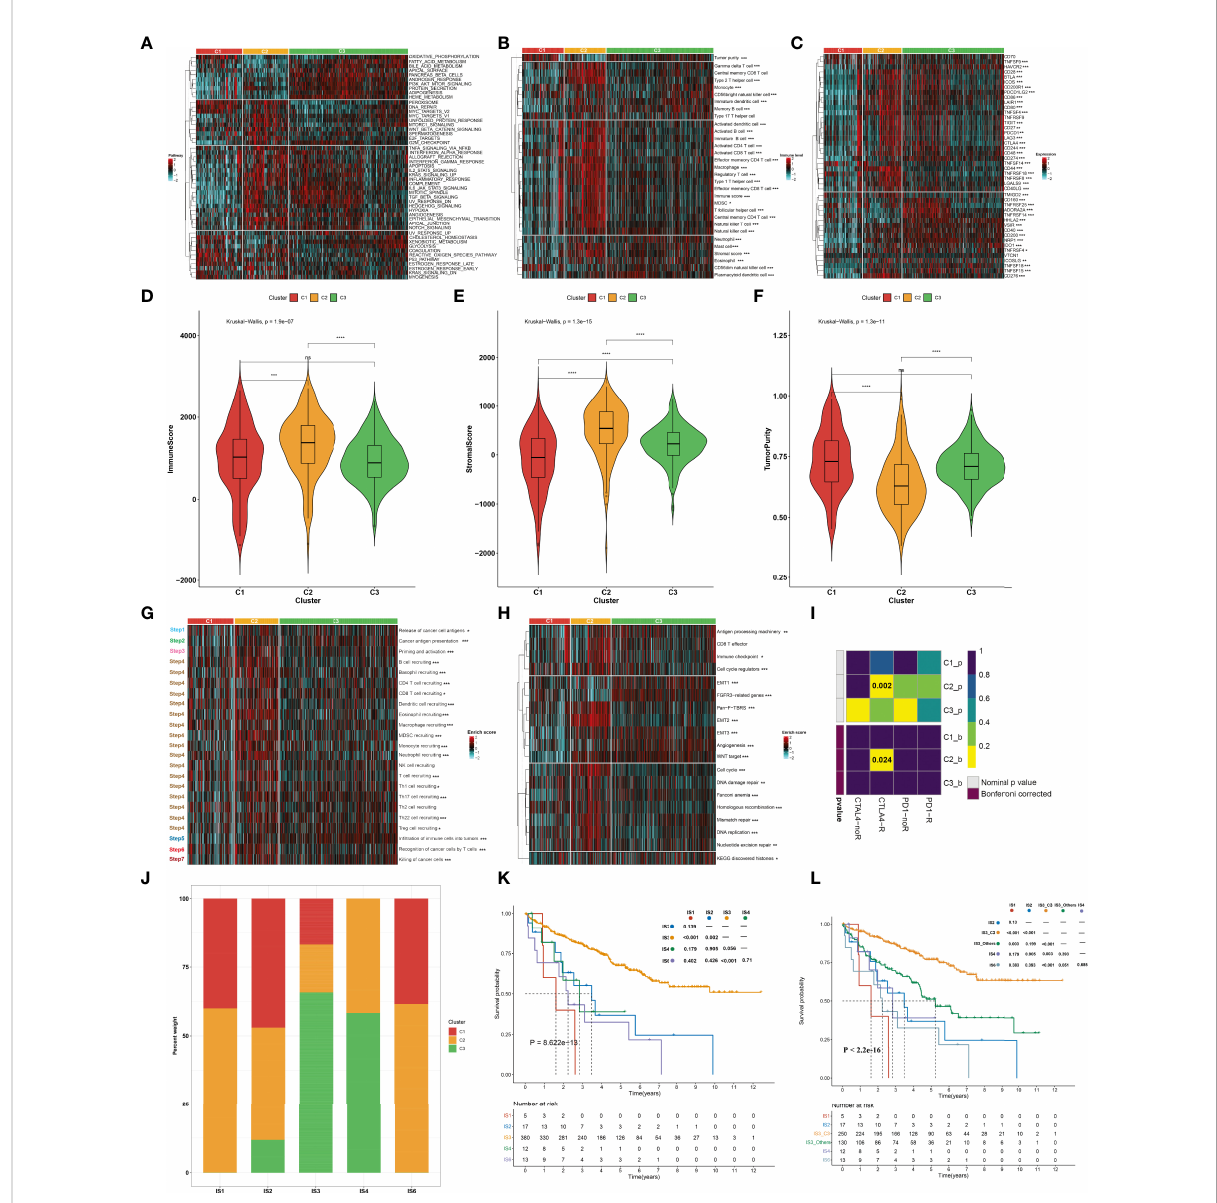
FIGURE 3 Immune landscape and antitumor immune responses of the three aging phenotypes in the TCGA-KIRC cohort. (A) Heatmap depicting the activities of hallmark pathways across the three aging phenotypes. Activated and inhibited hallmark pathways are colored by red and cyan, respectively. (B) Heatmap of the relative abundance of tumor-in fi ltrating immune cell populations across the three aging phenotypes. The high and low enrichment levels are colored red and cyan, respectively. (C) Heatmap of the RNA expression of immune checkpoint molecules across the three aging phenotypes. The high and low expression levels of immune checkpoints are marked by red and cyan, respectively. (D – F) Box plots of the differences in (D) immune and (E) stromal scores as well as (F) tumor purity across the three aging phenotypes. (G) Heatmap of the activation states of the seven steps within the cancer immunity cycle across the three aging phenotypes. Activated and inhibited steps are colored red and cyan, respectively. (H) Heatmap of the activities of known biological processes across the three aging phenotypes. Activated or inactivated processes are colored red or cyan. (I) Prediction of the response to anti-PD-1 and anti-CTLAL4 among the three aging phenotypes. R, response; noR, non-response. (J) Distribution of the three aging phenotypes across known immune subtypes. (K) Kaplan – Meier analysis for OS of the TCGA-KIRC cohort strati fi ed by immune subtypes. (L) Kaplan – Meier analysis for OS of the TCGA-KIRC cohort strati fi ed by immune subtypes and aging phenotypes. Ns, no signi fi cance; * P < 0.05; ** P < 0.01; *** P < 0.001; **** P <